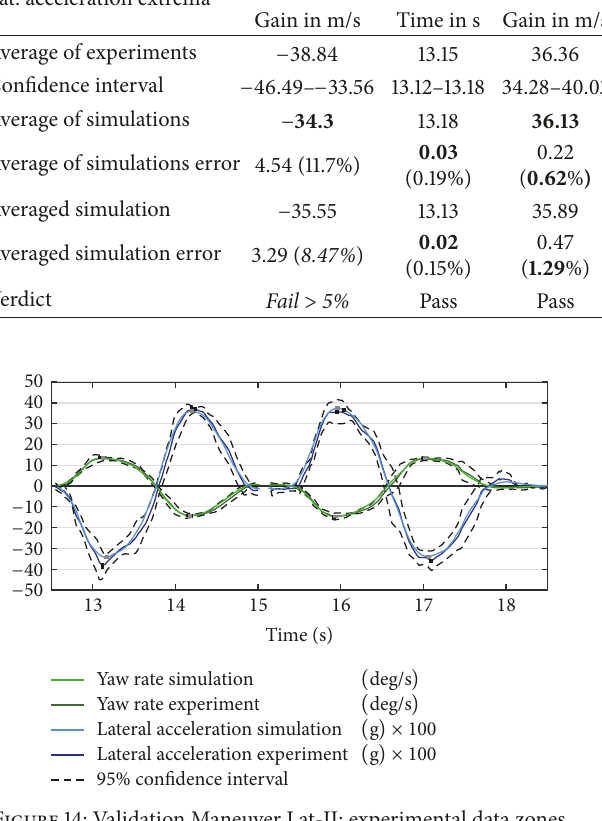
Figure 14: Validation Maneuver Lat-II: experimental data